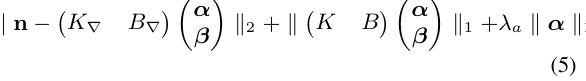
Figure 3: Demonstration of the plane regression with l 1 regular- ization and the augmented error slack variables. In both cases a) and in b) the normal vectors to every point are random. The noise in the point positions is a) uniformly and b) non-uniformly